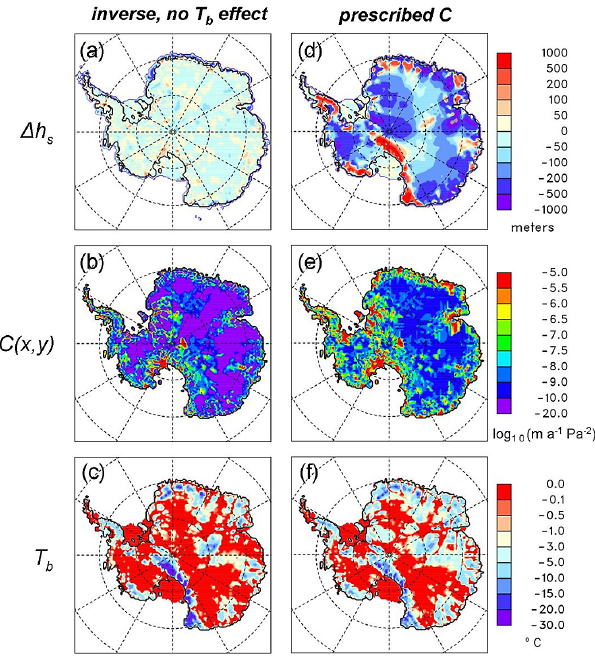
Fig. A1. Poor results using inverse method with no basal- temperature effect on sliding. Top row: model minus observed sur- face ice elevation, meters. Middle row: basal sliding coefficients C(x,y) , log 10 (ma − 1 Pa − 2 ) . Bottom row: homologous basal tem- peratures T b , ◦ C. Left column (a–c) : using basic inverse method (no sub-grid topographic influence) and with no effect of basal tem- perature T b on sliding. Right column (d–f) : non-inverse run using prescribed C(x,y) , nearest-neighbor filled from (b)